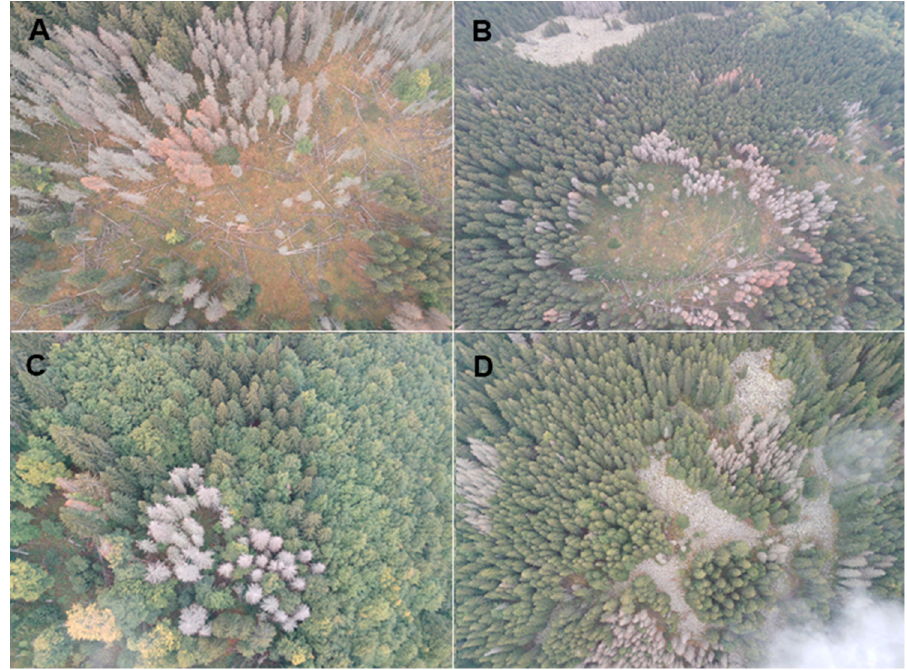
Figure 6. Spruce stands under attack by Ips typographus : ( A )—expanded bark beetle spot; ( B )—merged bark beetle spots; ( C )—emerged bark beetle spot; ( D )—bark beetle spots near rock screes. 3.2. Ips typographus Attacks on the Entire Territory of the Chuprene Reserve The satellite images showed that on the entire territory of the Chuprene Reserve (1451.9 ha), I. typographus killed spruce trees on 137.4 ha, that is, 9.6% of the total area. The map shows that the oldest I. typographus attacks, respectively the largest outbreaks and drying of spruce stands, occurred in the northern (lower) part of the reserve (Figure 7).